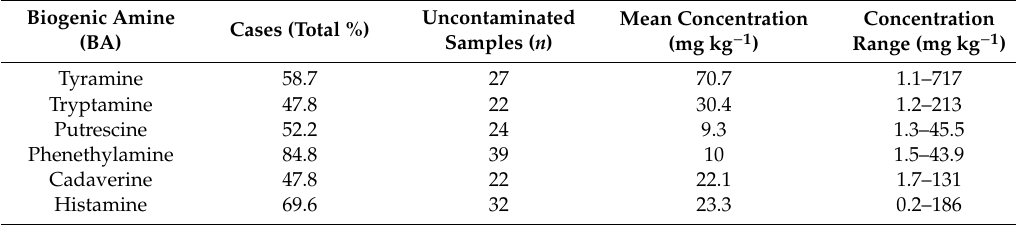
Table 4. The concentrations of biogenic amines found in blue cheese samples.